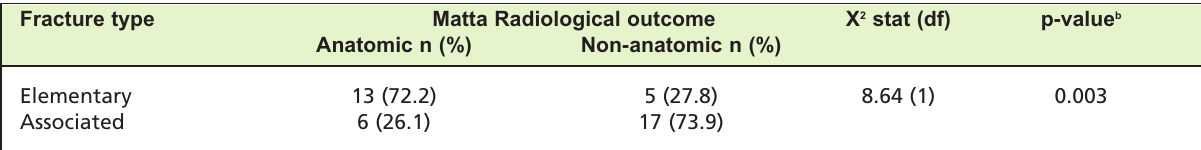
Association between acetabular fracture pattern and anatomic/non-anatomic Matta Radiological outcome Table III: (n= 41, exclude 2 physeal injuries) Fracture